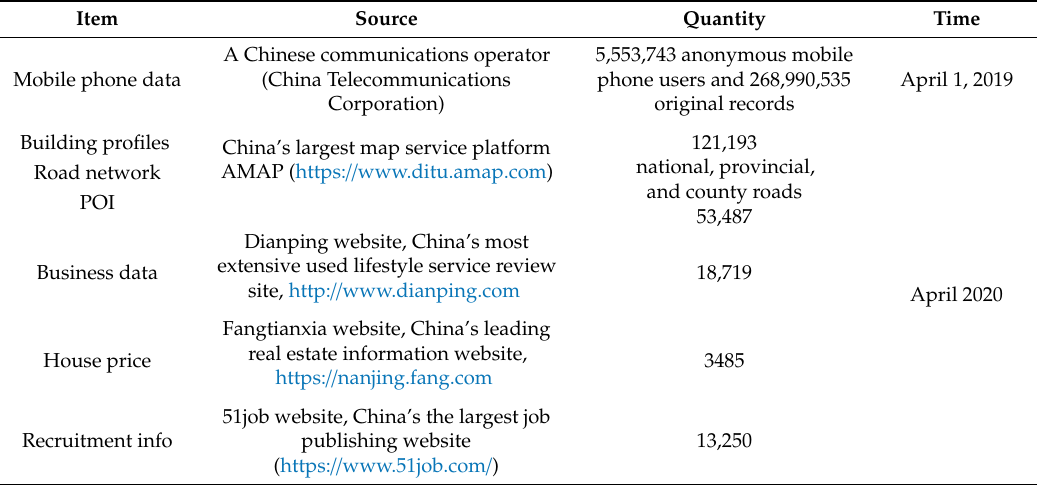
Figure 3. The geographic location of the study area and the construction of urban business districts. The picture in the upper left shows the location of Nanjing city, and below it is the administrative divisions and the study area boundary in Nanjing city. The right picture shows the distribution of 43 urban business districts in this study area at street scale. Table 4. A detailed description of the data source used in our empirical research.